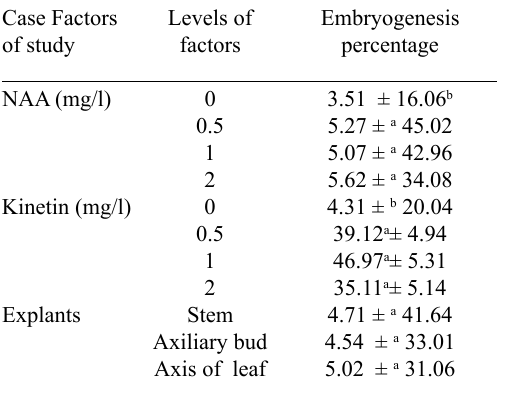
*Numerical data with the similar alphabetical indices, based on Duncan’s Compare Mean at the probability level of 5 percent are not significantly